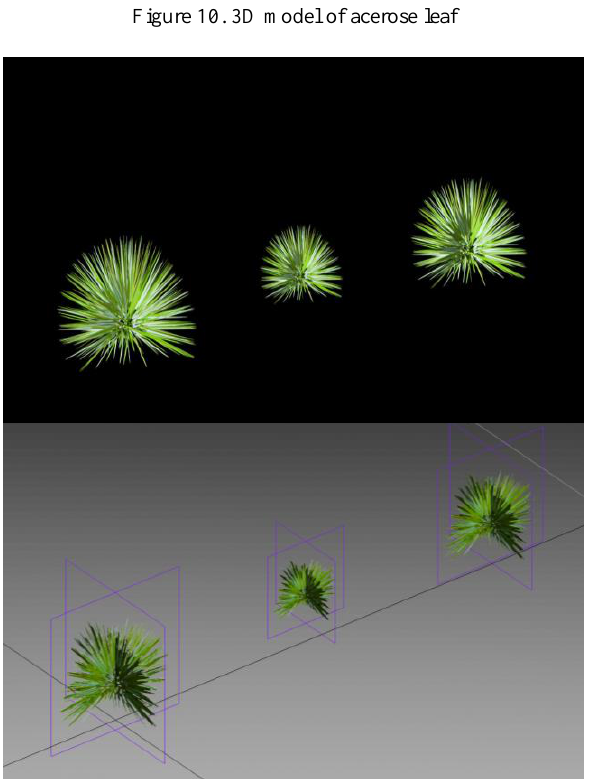
Figure 11. Expression by two